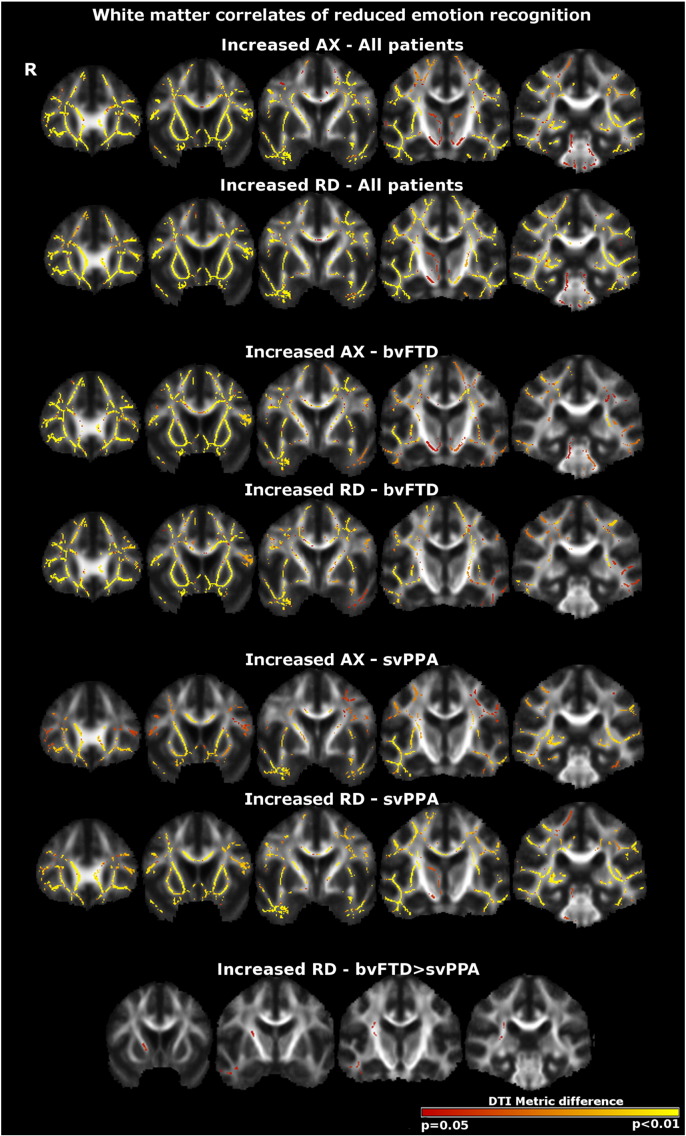
White matter correlates of reduced emotion identification performance in both patient groups (top panels), the bvFTD group alone (middle panels) and the svPPA group alone (bottom panels). Results are overlaid on a customised group template brain image and displayed in MNI standard space; the right hemisphere (R) is displayed on the left. The colour scale indexes p-value after family-wise error correction over the whole brain at p < 0.05. Key: AX, axial diffusivity; bvFTD, behavioural variant frontotemporal dementia; RD, radial diffusivity, svPPA, semantic variant of primary progressive aphasia.